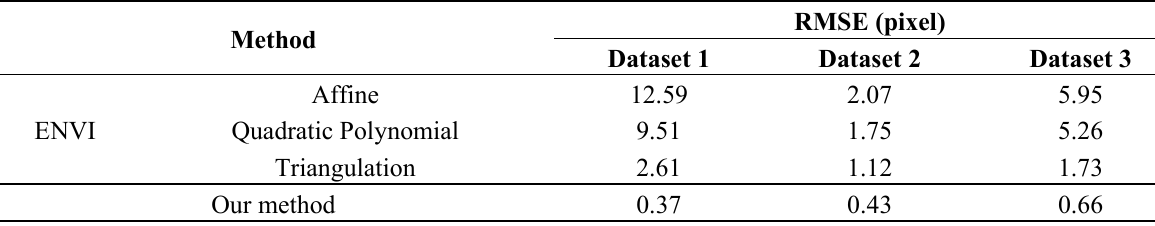
Table 5. Results of registration accuracy.